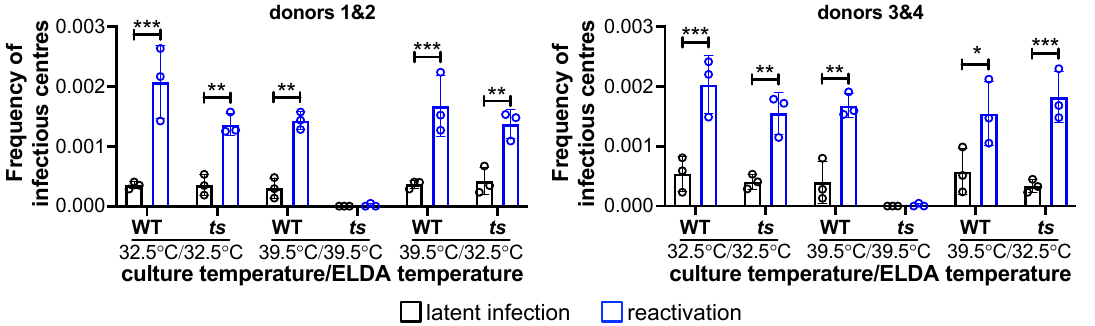
Figure 3. CD34 + HPCs infected with ts C510G at the non-permissive temperature successfully reactivate from latency when shifted to the permissive temperature. CD34 + HPCs were infected (moi = 2.0 TCID 50 /cell) with WT or ts C510G ( ts ) and maintained in media favoring latency (latent infection, black bars) at the indicated culture temperature (7 d). Half of each infected population was then cultured in reactivation media (reactivation, blue bars) at the indicated reactivation temperature. Each infected population was co-cultured with naïve NuFF-1 cells (14 d), and the frequency of infectious centers was calculated by ELDA. Two biological replicates are shown, each of which contained pooled donor cells. Each data point (circles) represents a technical replicate ( n = 3 per condition). Error bars indicate SD; statistical significance was calculated using two-way ANOVA followed by Tukey’s post hoc analysis. * p < 0.05, ** p < 0.01, *** p < 0.001.